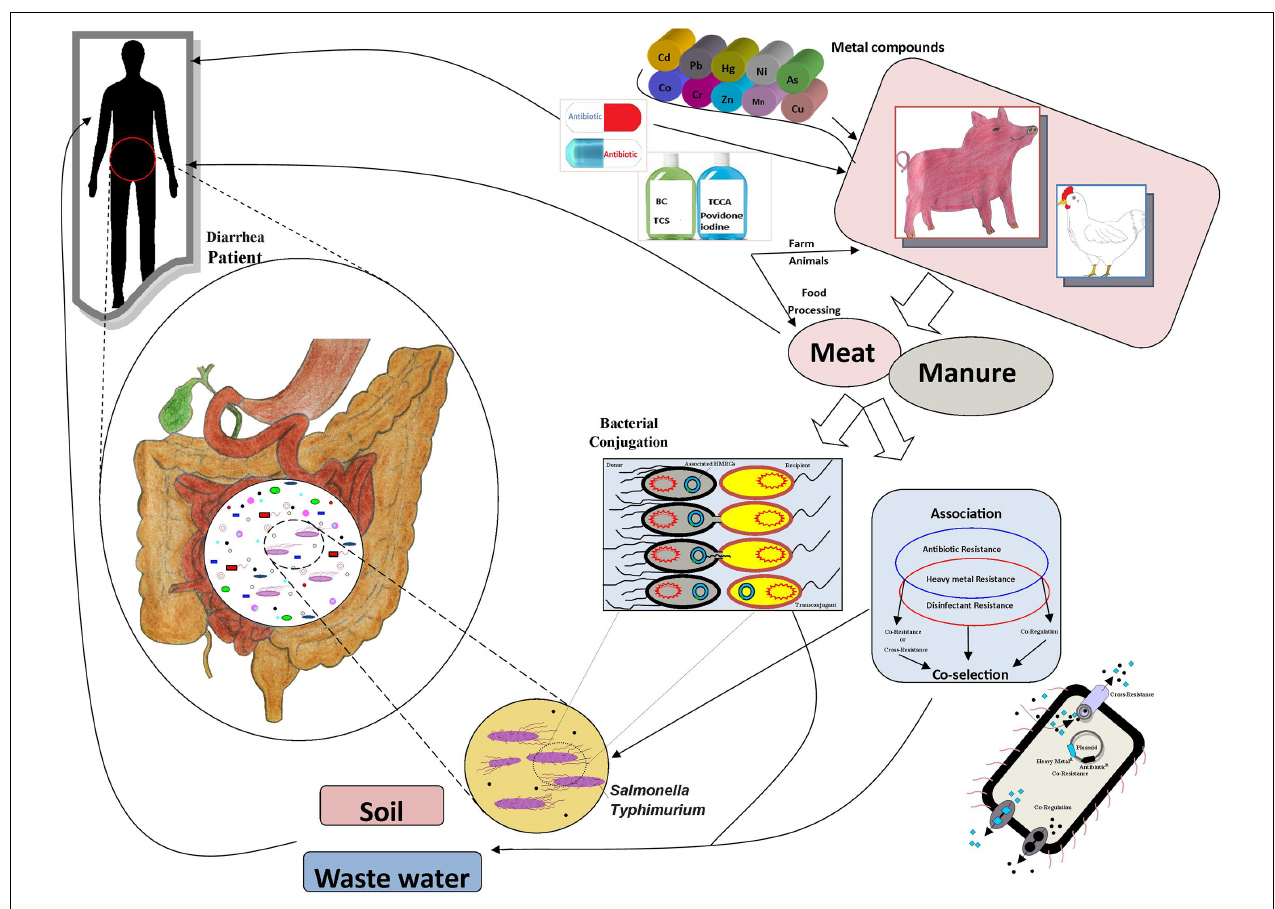
FIGURE 1 | The associations and transmission routes of metal, antibiotic, and disinfectant